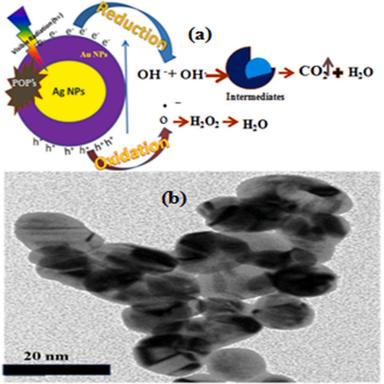
(a). Schematic diagram of degradation mechanism (b) TEM image of Au/Ag-NPs after degradation.